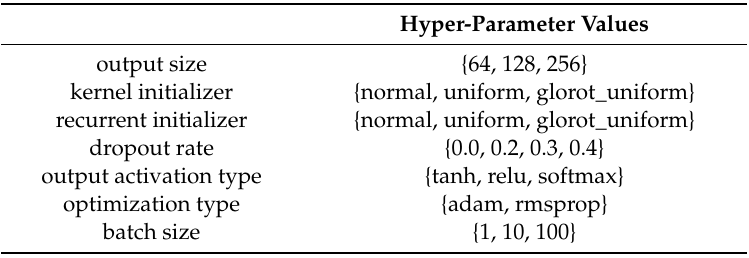
Table 1. The grid search hyper-parameter sets for the LSTM model.